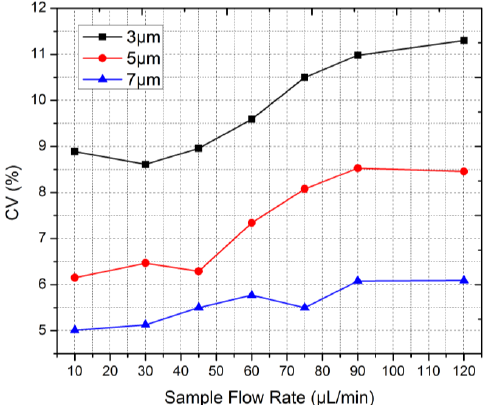
Figure 9. An analysis of 3, 5, and 7 μm microbeads was conducted by the microflow cytometer under different sample flow rates, and the sheath flow was kept at 7.2 mL/min to make the focusing chip operate at the optimal velocity. Table 1. Coefficient of variations (CVs) (%) of microbeads detected by the microflow cytometer and commercial instruments.